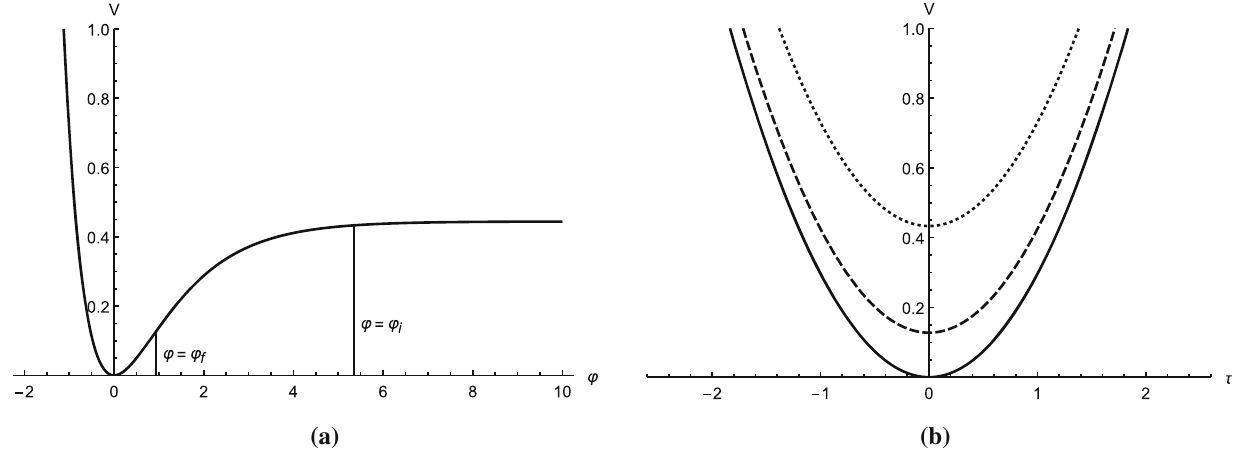
Fig. 1 The scalar potential of (22) for μ = 2 ,λ = 1 and V 0 = 0. Subfigure a represents ϕ -dependent slice ( τ = 0), while Subfigure b represents τ -dependent slice for different background values of ϕ : solid line stands for ϕ = 0, dashed line for ϕ = ϕ